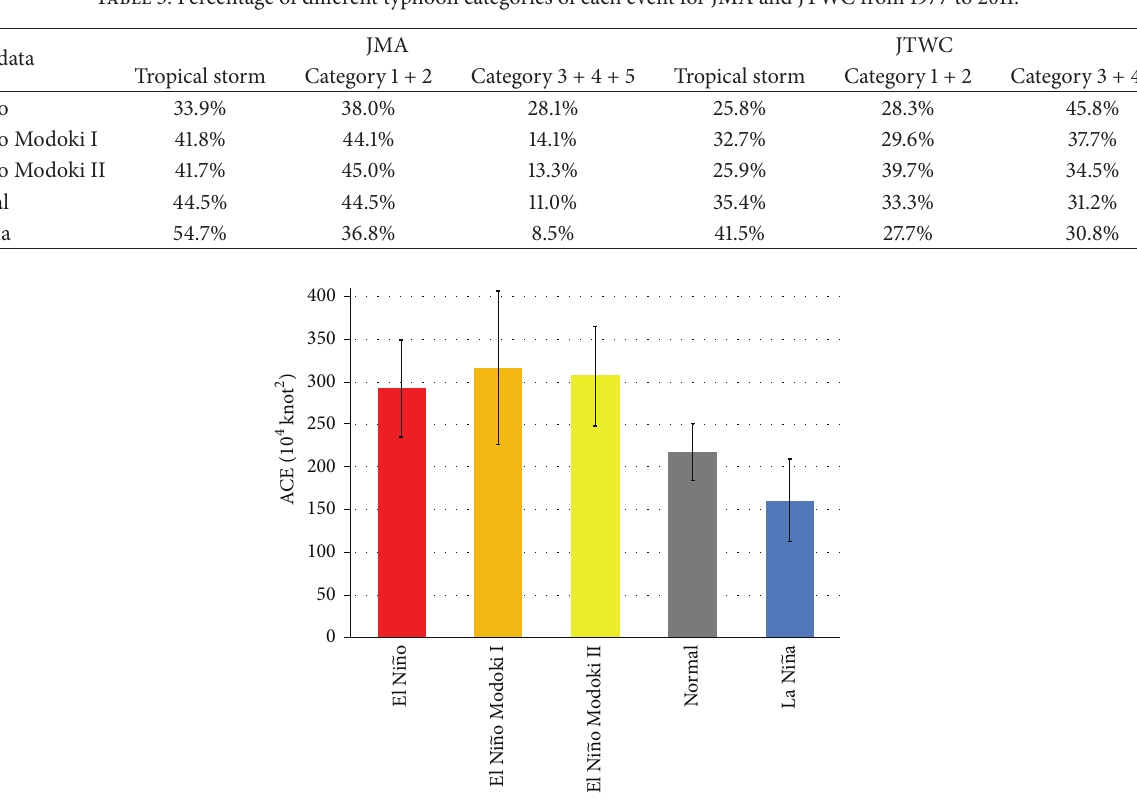
Table 3: Percentage of different typhoon categories of each event for JMA and JTWC from 1977 to 2011.